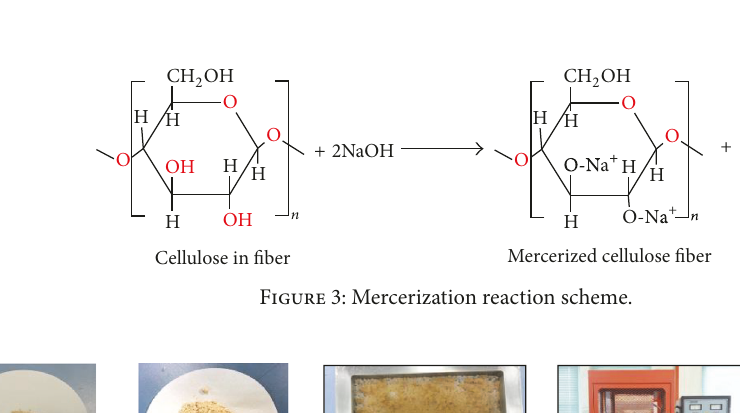
Figure 2: Peracetic acid solution reaction scheme.